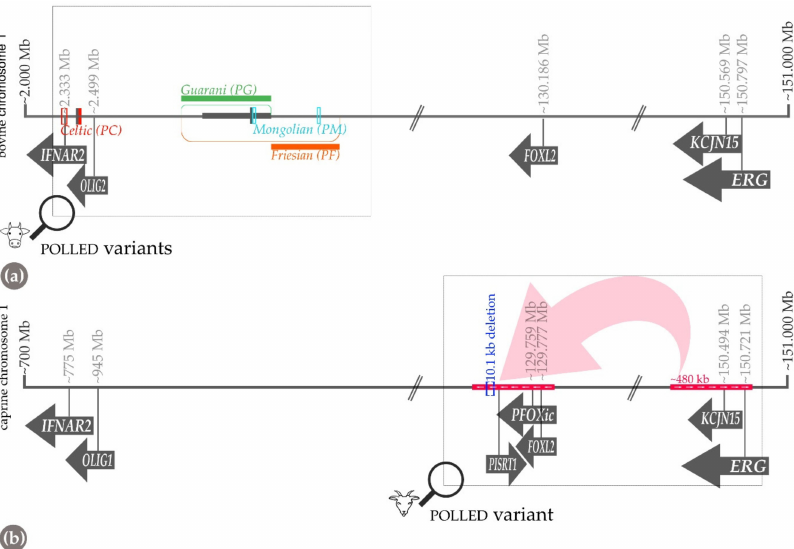
Figure 3. Schematic representation of the location of the different known polledness-causing variants on bovine ( a ) and caprine ( b ) chromosome 1. Note the corresponding genes annotated in both species have been drawn one below the other for simplicity but are in different positions on the respective chromosome. The coordinates refer to the current reference genome of cattle (ARS-UCD 1.2) and goat